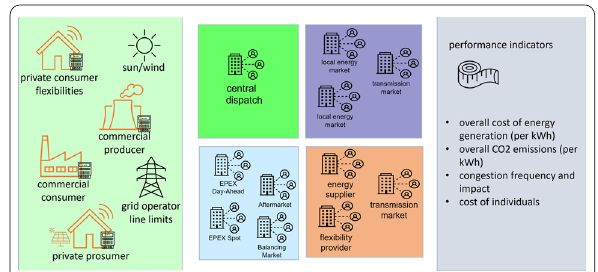
Fig. 1 Outline of the framework to provide comparability of different market rule‑sets The general targets of such a market design, anchored for example in the German EnWG §1, are generally known